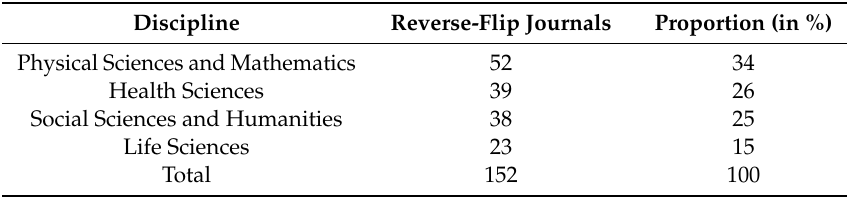
Table 1. Reverse-flip journals by discipline [66].